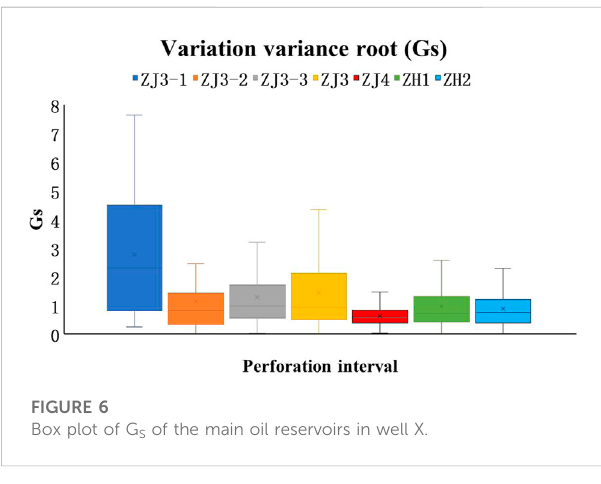
FIGURE 6 Box plot of G S of the main oil reservoirs in well X.